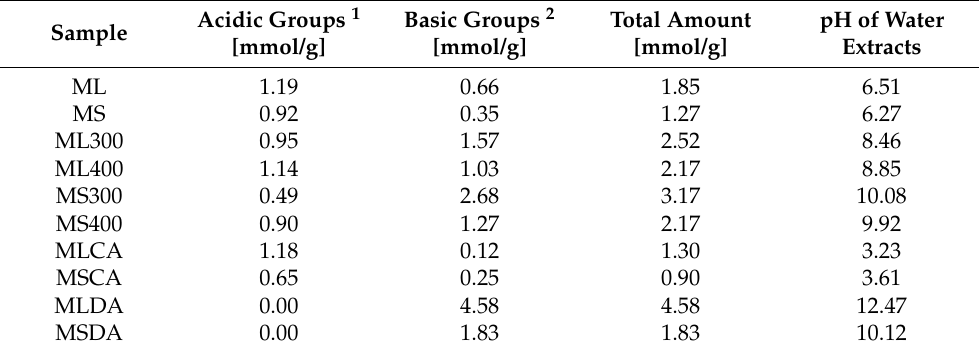
Table 3. Acidic-basic properties of the precursors, biochars and activated biocarbons